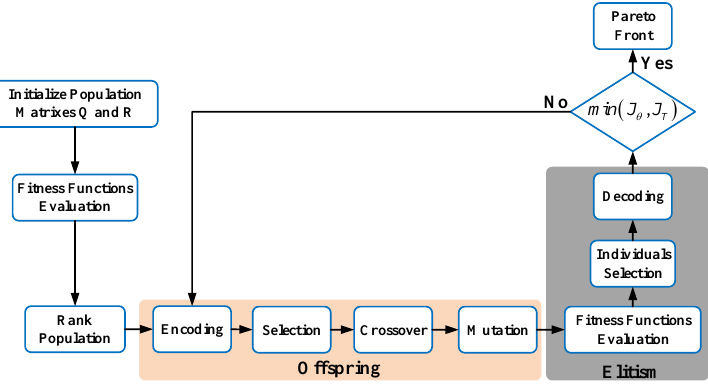
Figure 4. Flowchart of multi-objective genetic algorithm.